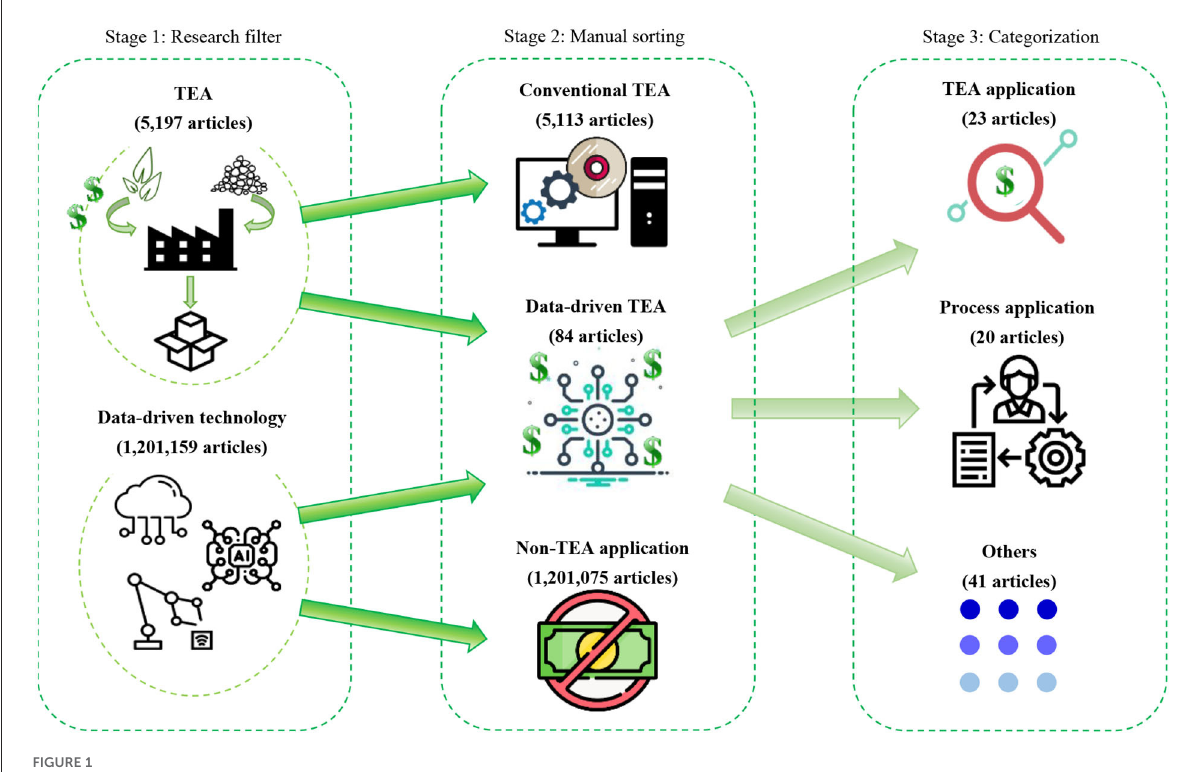
FIGURE1 Bibliometric analysis flow